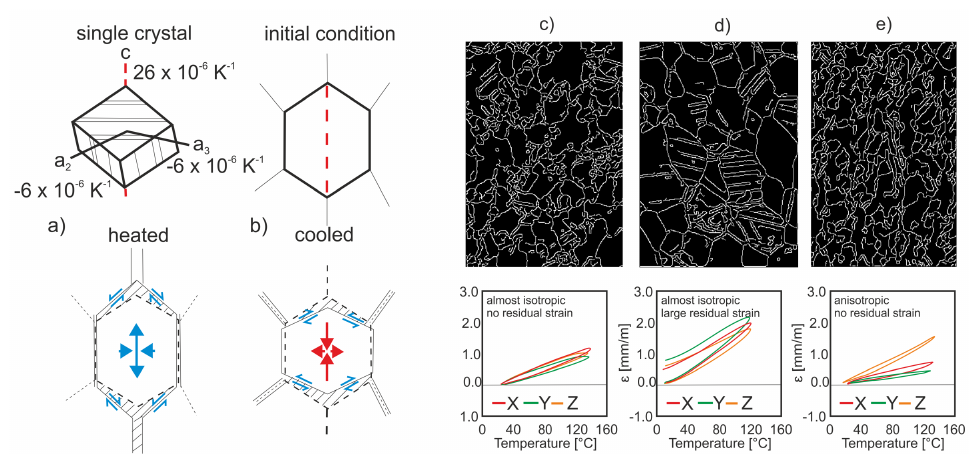
Figure 1. Anisotropic thermal expansion of calcite crystals. Adopted from [1].